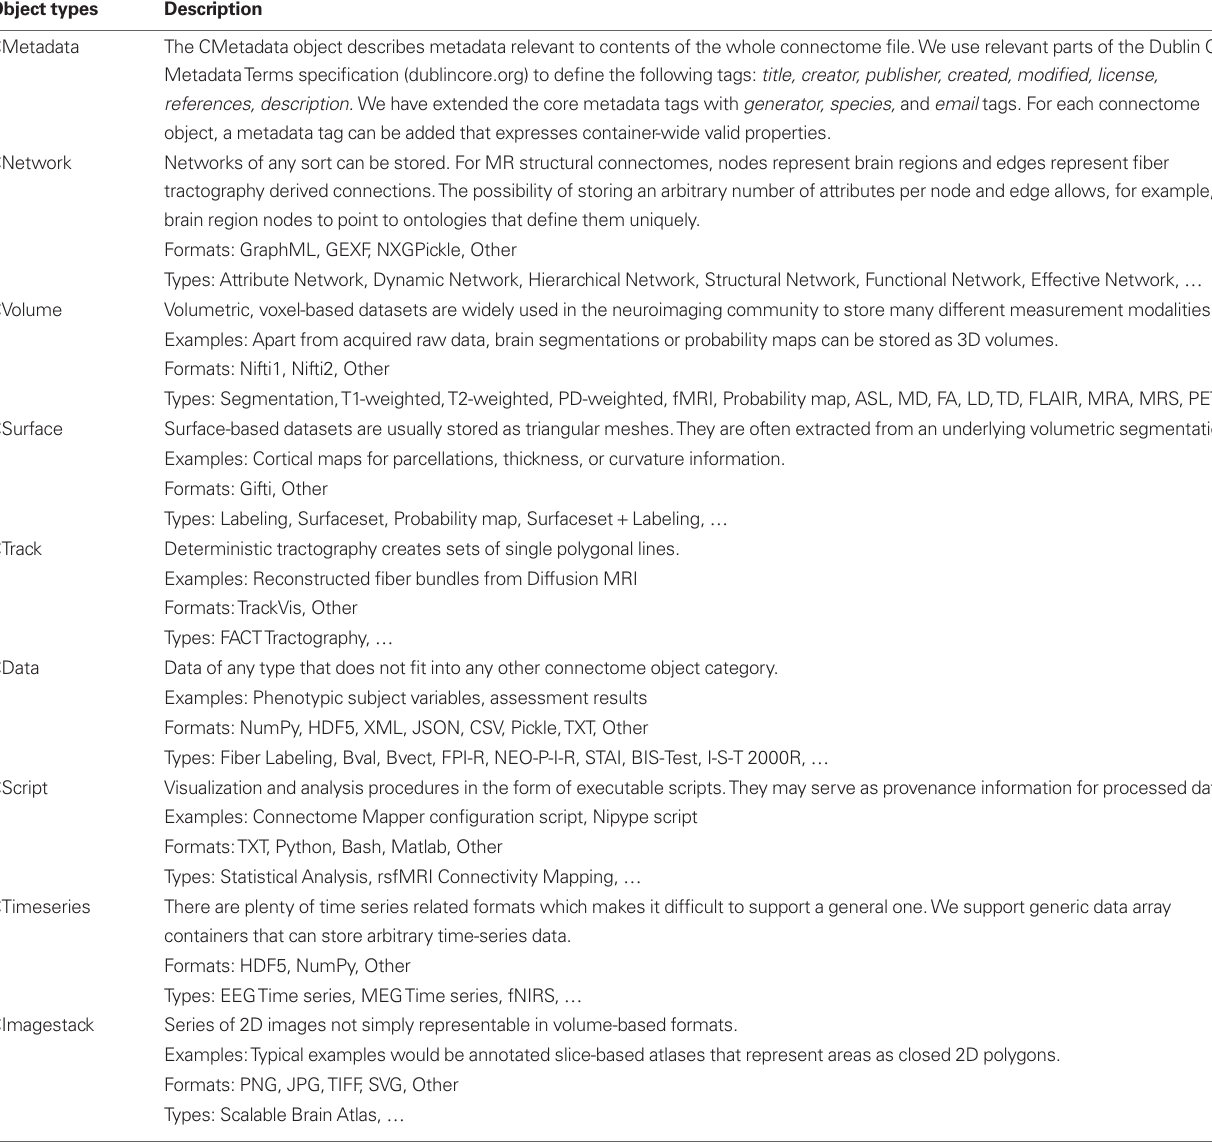
Table 1 | The variety of connectome objects the CFF